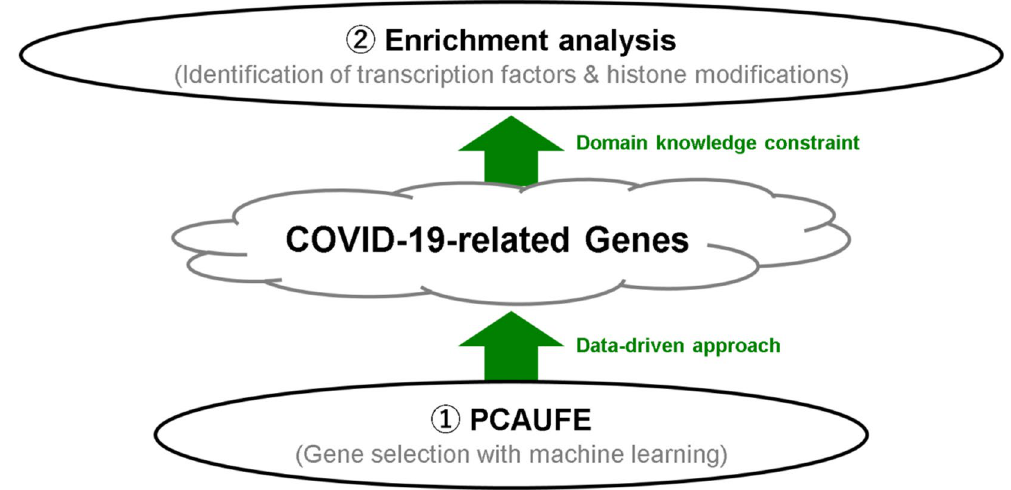
Figure 1. Outline of this study. First, we select genes related to the disease by using unsupervised machine learning; then, we enrich them by applying biological knowledge to identify the transcription factors and histone modifications of the selected